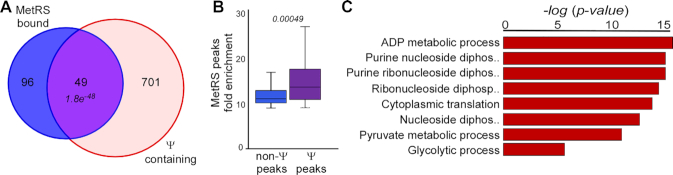
MetRS binds Ψ-enriched regions. (A) Venn diagram was generated from peaks identified as bound by the MetRS fRIP-seq analyses and specific mRNA ribonucleotide that was found to contain pseudouridine by Ψ-mapping studies (17–19). P-value was calculated by the Hypergeometric test. (B) MetRS bound peaks were separated into those that do not contain Ψ (non-Ψ) and those that do. Box plot presents the fold enrichment in binding compared to untagged control. P -value was calculated by the two-tailed t-test. (C) GO terms processes analysis was done to Ψ-containing peaks genes that are bound by MetRS using SGD GO Term Finder Version 0.86.